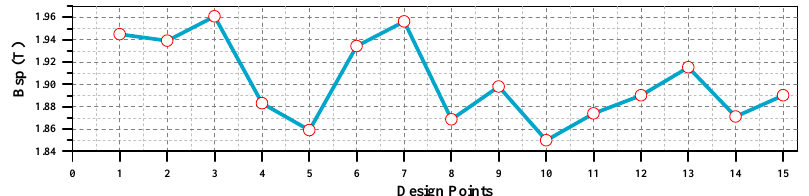
Figure 6. Target parameter of B sp with design